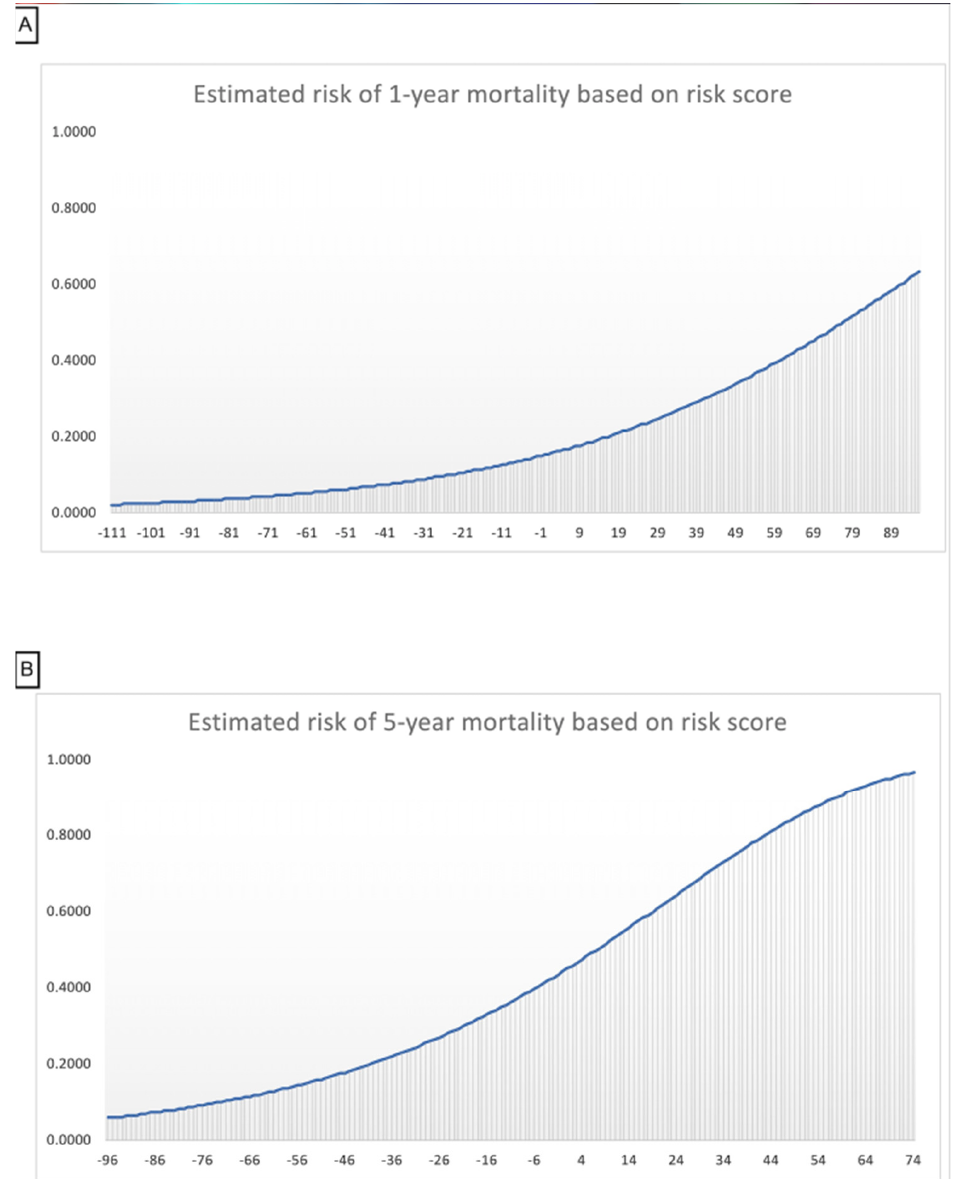
Figure 3. Risk of mortality based on risk scores. Panel ( A ): risk of 1 − year mortality for risk scores. Panel ( B ): risk of 5 − year mortality for risk scores.